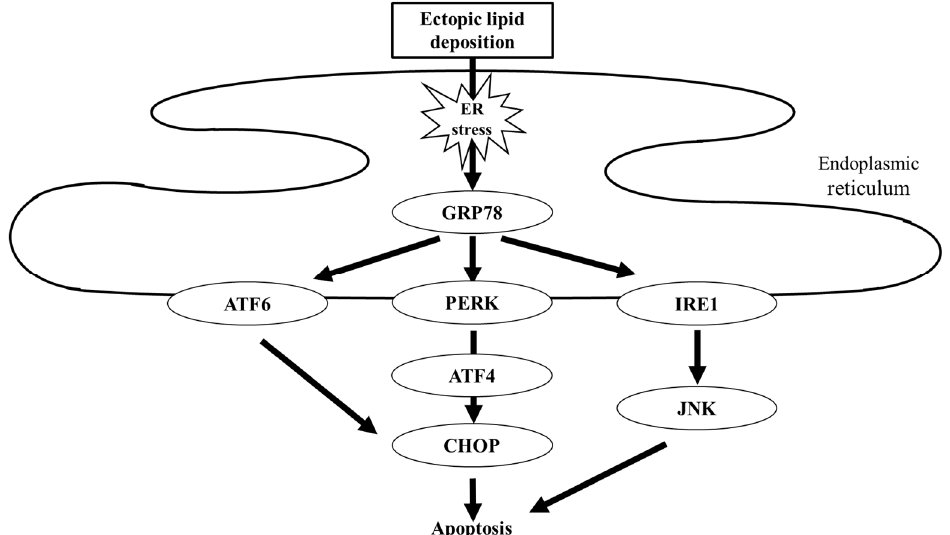
Figure 3. Schematic of lipotoxicity-related ER stress. Ectopic lipid deposition induces ER stress. Excessive ER stress is sensed by three different mediators, namely ATF6, PERK, and IRE1, resulting in cellular apoptosis. GRP78, glucose-regulated protein-78; ATF, activating transcription factor; PERK, PKR-like endoplasmic reticulum kinase; IRE1, inositol requiring 1; and CHOP, C/EBP homologous protein.